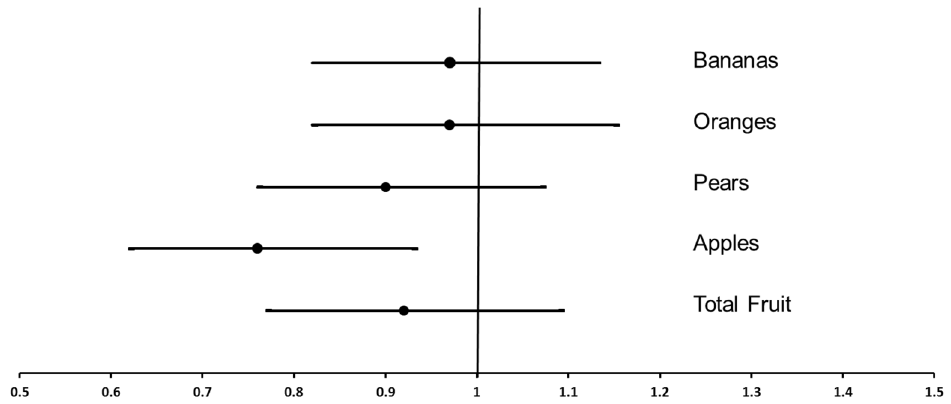
Figure 1. The odds ratio and 95% confidence interval of severe abdominal aortic calcification for each SD increase in total fruit, apple, pear, banana and orange intake. Multivariable adjusted for age, BMI, energy intake, energy expended in physical activity, alcohol consumption, prevalent atherosclerotic vascular disease, previous type 2 diabetes, use of antihypertensive medication, use of cholesterol ‐ lowering medication (statins), and smoking status.